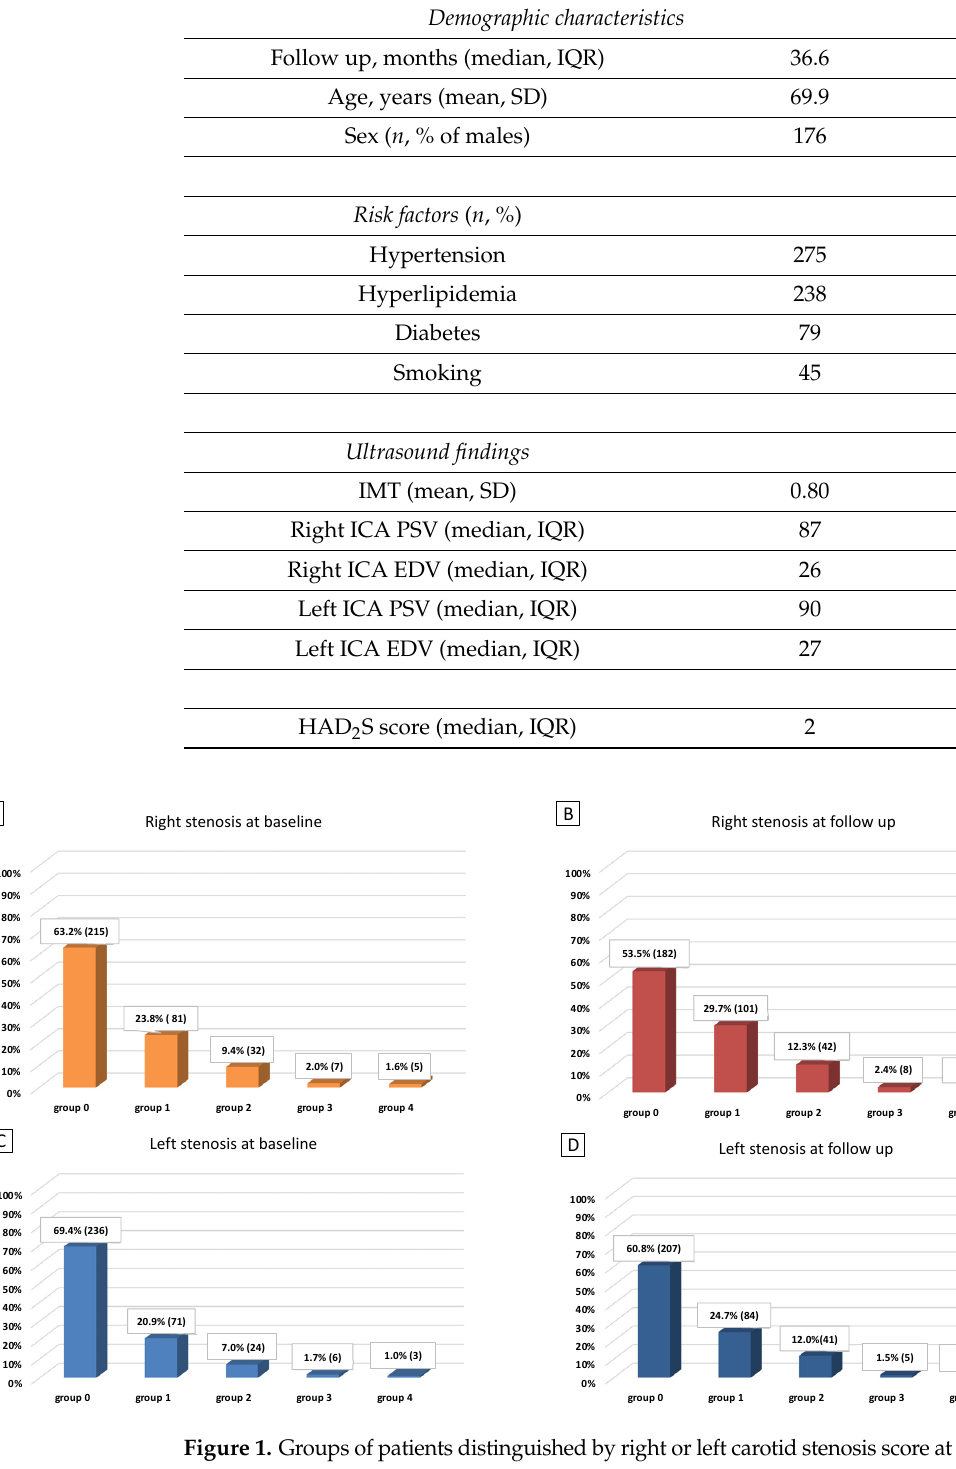
Table 1. Demographic characteristics, ultrasound findings, percentage of vascular risk factors and the median HAD 2 S score at baseline.